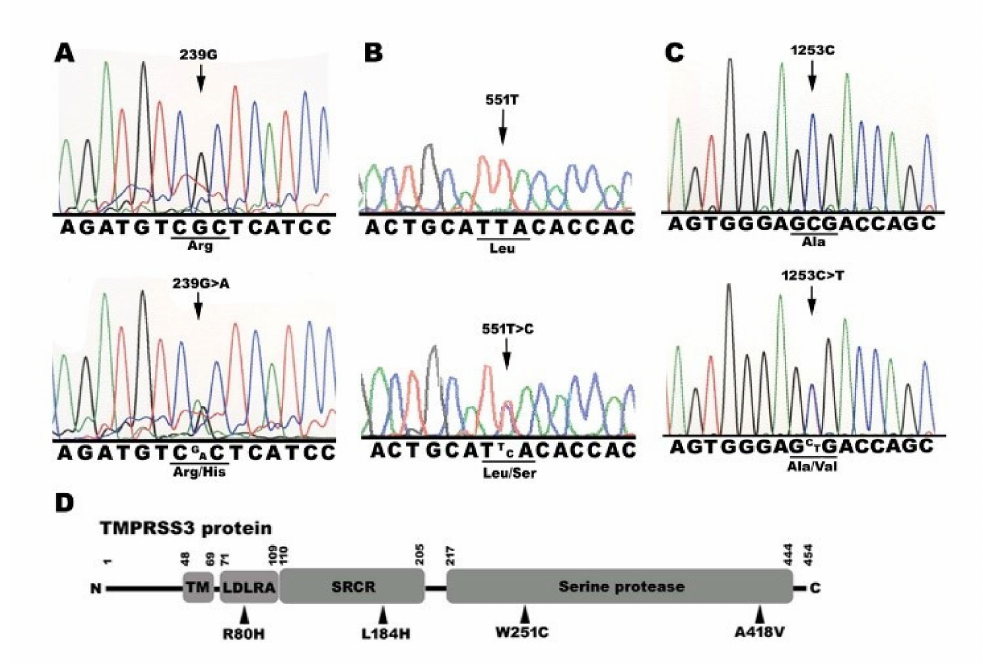
Figure 1. Sequence analysis of TMPRSS3 genomic DNA variants in 230 patients with nonsyndromic hearing loss. Three variants of the TMPRSS3 gene were found in this study, three heterozygous missence variants: ( A ) c.239G > A, ( B ) c.551T > C, and ( C ) c.1253C > T. ( D ) Schematic representation of the